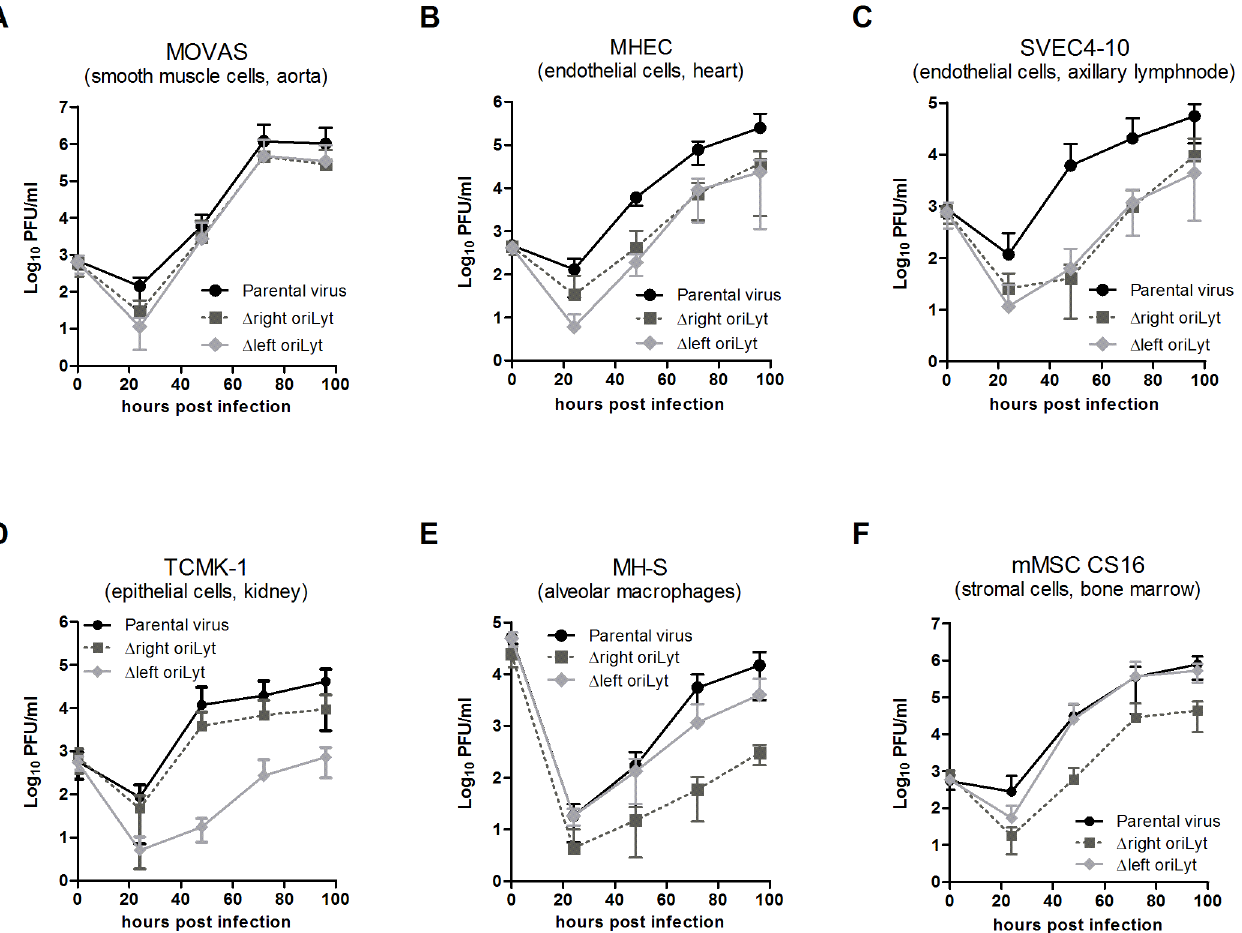
Fig 1. Virus replication in vitro. MOVAS (A), MHEC (B), SVEC 4 – 10 (C), TCMK-1 (D), MH-S (E) and CS16 stromal cells (F) were infected with the indicated viruses at an MOI of 0.01 (MOVAS, MHEC, SVEC 4 – 10, TCMK-1, CS16) or 1 (MH-S). Cells and cell culture supernatants were harvested at different time points p.i., and titers were determined by plaque assay on BHK-21 cells. Data shown are the means ± SD from three (SVEC 4 – 10 and MH-S), four (MOVAS and MHEC) or five (TCMK-1 and mMSC CS16) independent